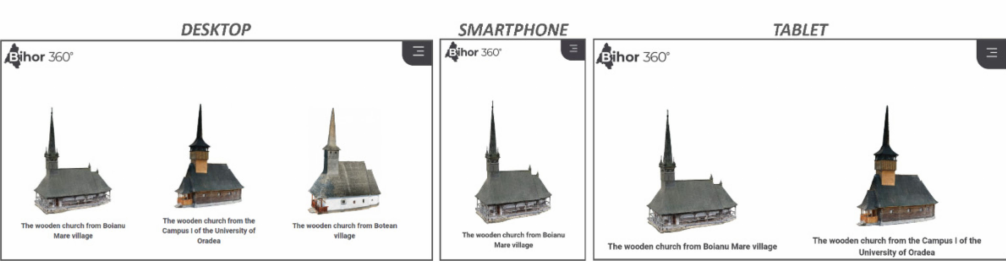
Figure 10. The website interface accessible from desktop computers, smartphones, and